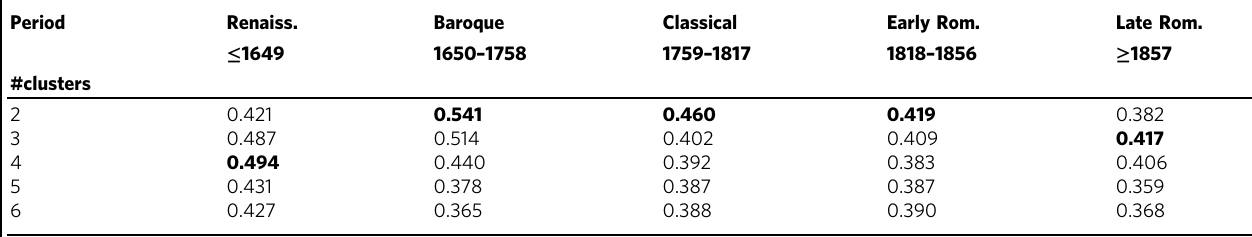
Table 1 Silhouette scores for each time period and different numbers of modes. Period Renaiss.